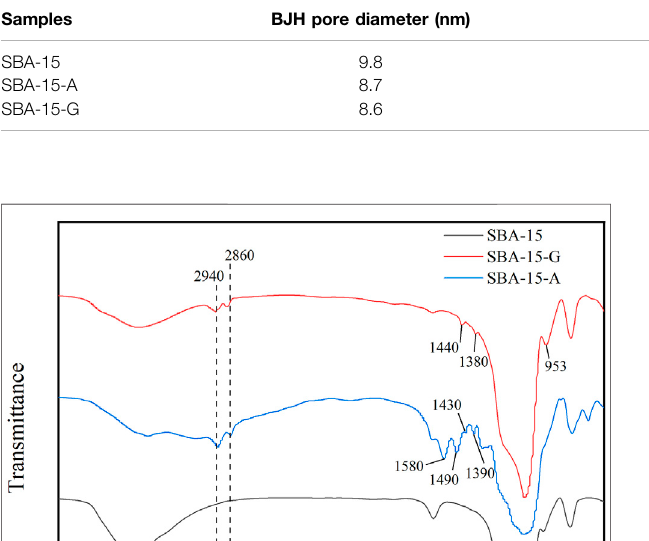
TABLE 1 | Speci fi c structural parameters of SBA-15, SBA-15-A, and SBA-15-G. Samples